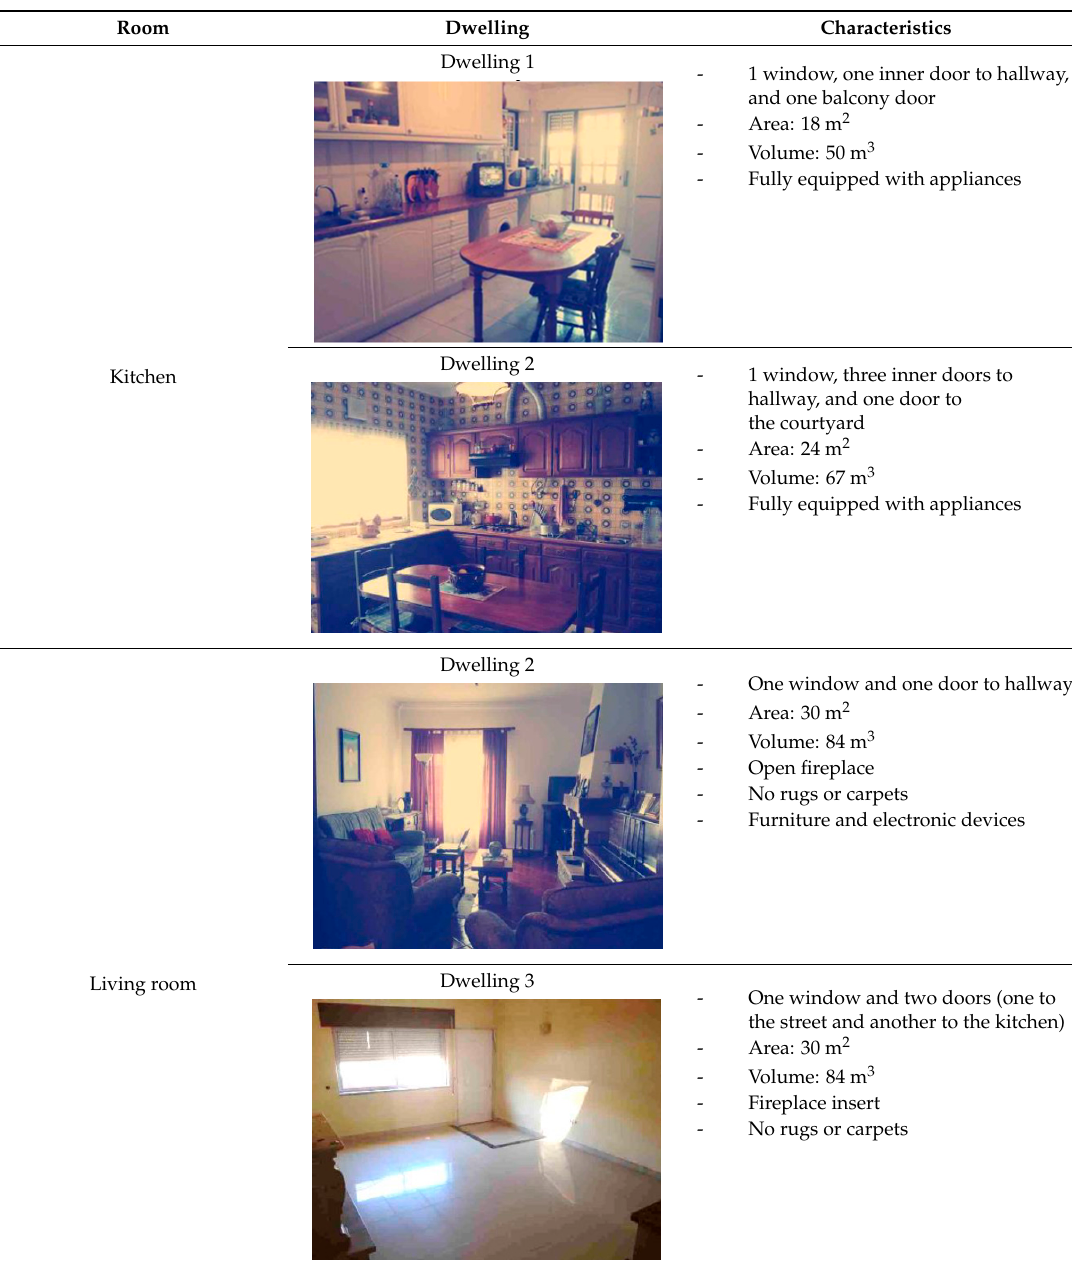
Table 2. Characteristics of the studied rooms.